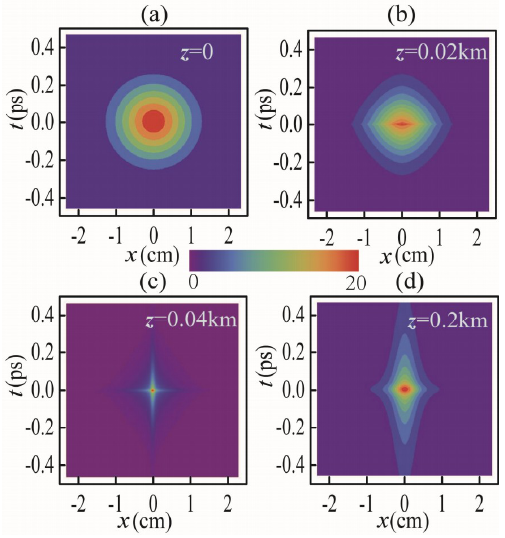
Figure 8. Contour graph of normalized spatial-temporal intensity distribution I ( x , t , z ) of PCP beams with Gaussian weight function at z plane with different values of z : ( a ) z = 0, ( b ) z = 0.02 km, ( c ) z = 0.04 km and ( d ) z = 0.2 km in the x - t plane.